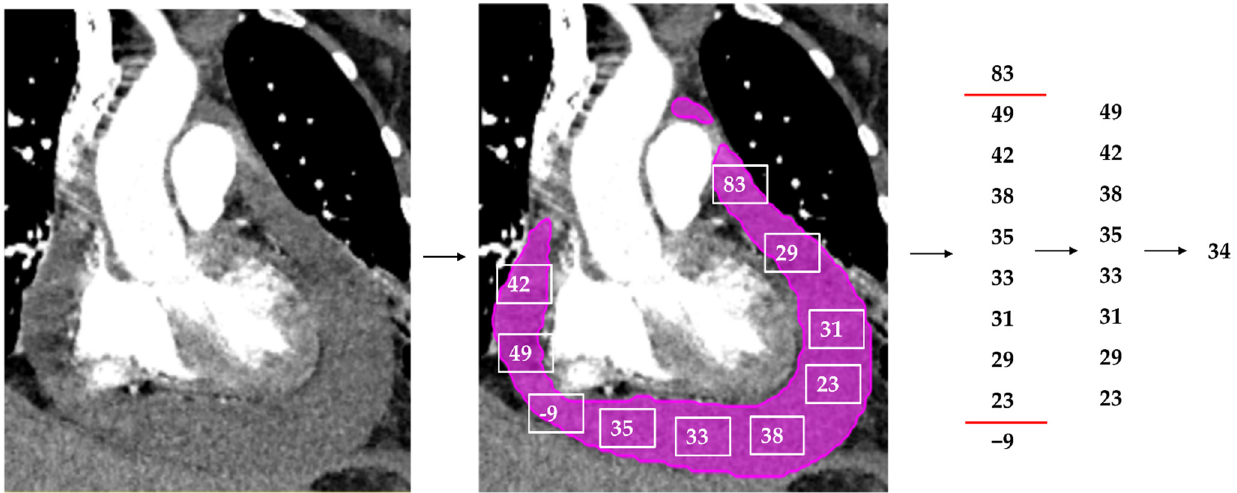
Figure 2. Simplified overview of the median Hounsfield unit (HU) extraction from an example CT with hemopericardium. A CT study with contrast depicting hemopericardium is segmented by the model (pink). Every voxel within the prediction mask generates a HU, visually depicted as the white squares with numbers within. All HUs outside of 0 to 80 are removed. The median HU of this PEF is selected using the remaining HUs and is the output (in this example 34 HU).